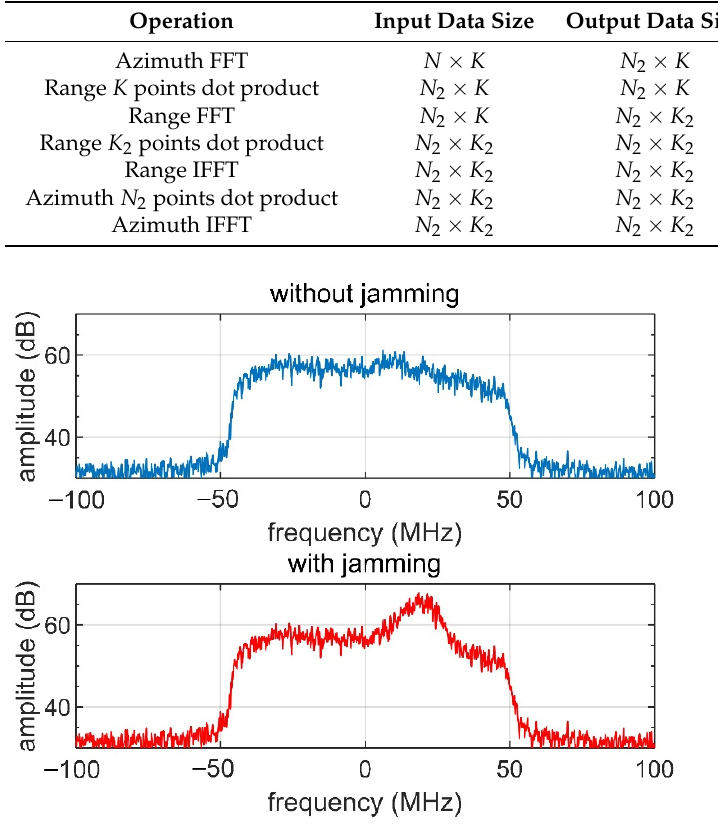
Figure 6. Spectrum without jamming and with 0 dB jamming. Table 1. The major time cost of the CS algorithm.